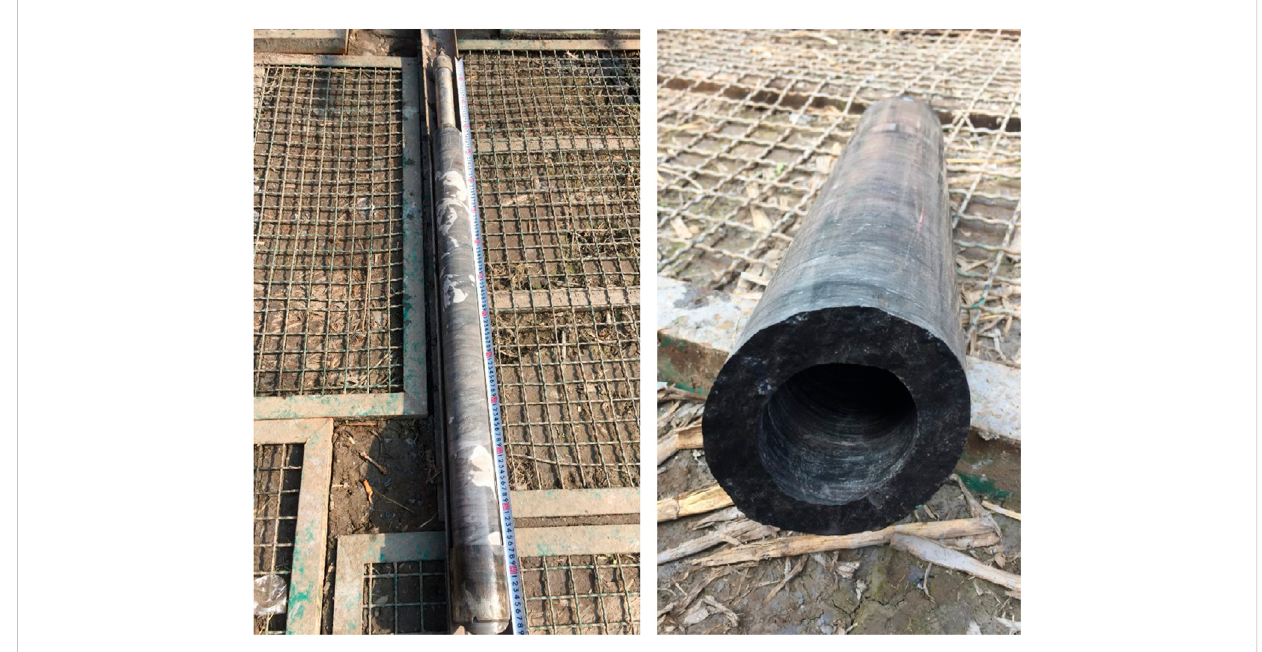
FIGURE 7 Photos of site application (the device and ring core are successfully recovered from the